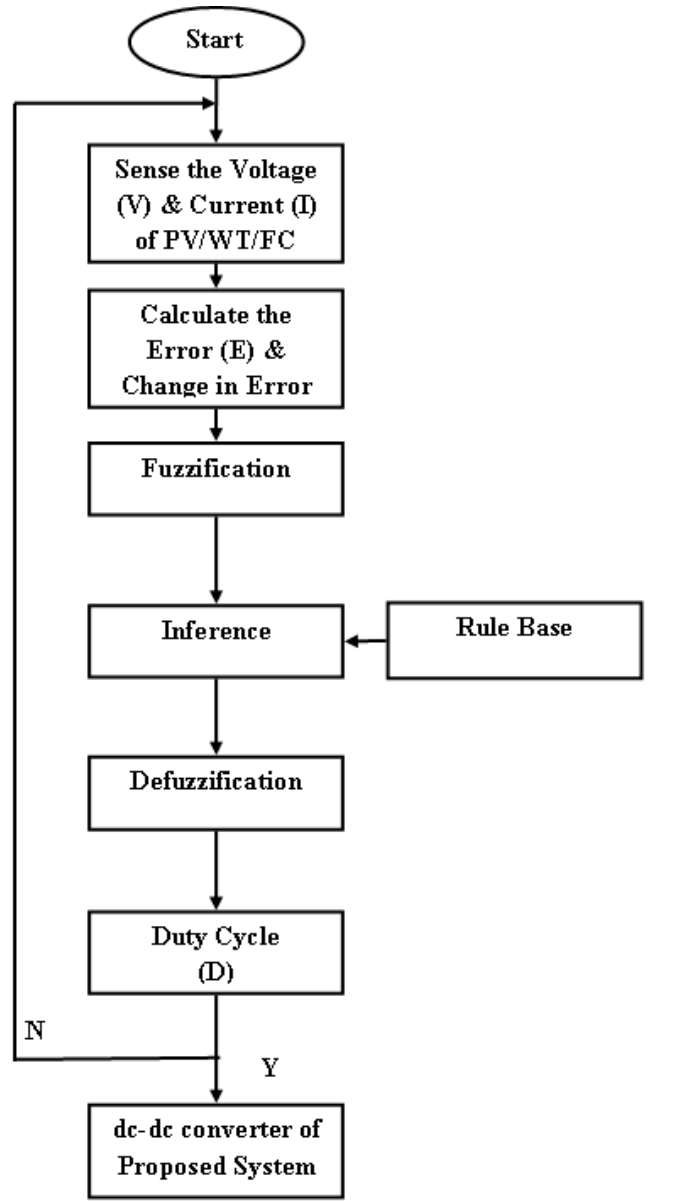
Figure 13. Flowchart calculation using the FL controller for PV/W/FC.